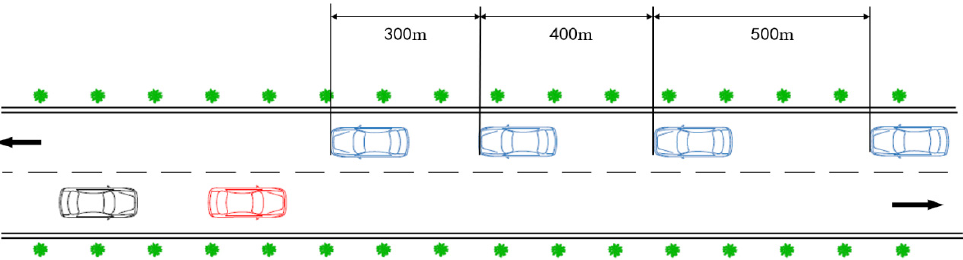
Figure 6. Schematic diagram of overtaking dynamic